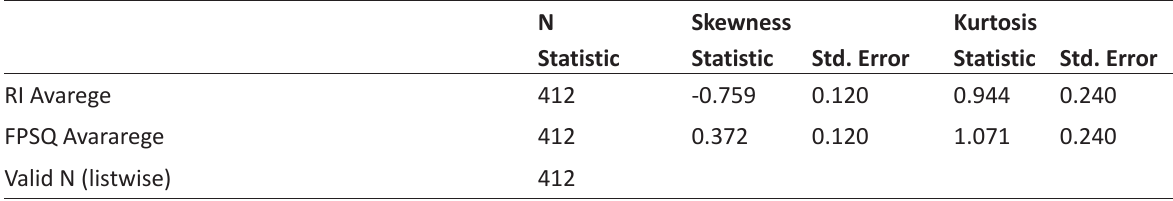
Table 2. Test of Normality of the two scales